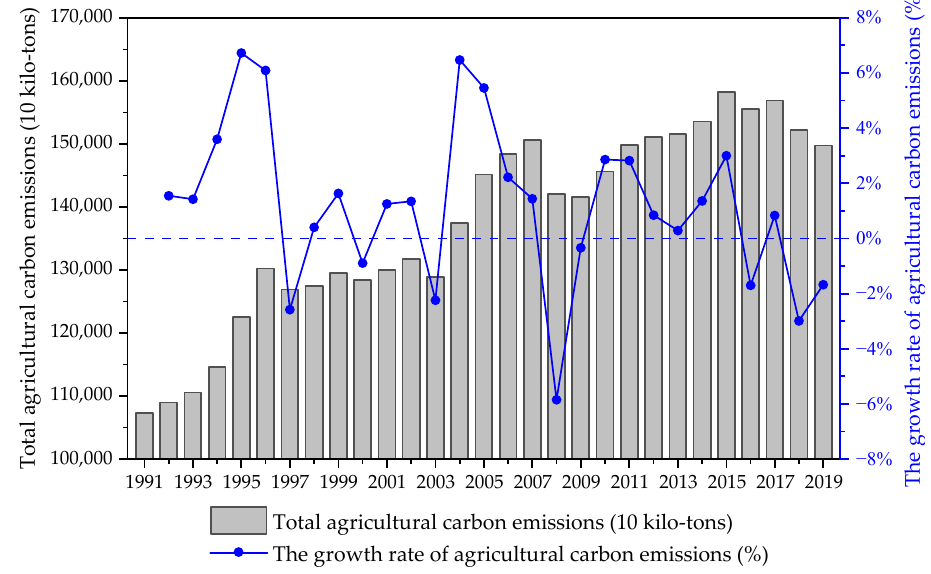
Figure 2. Total agricultural carbon emissions and their growth rates in China, 1991–2019.